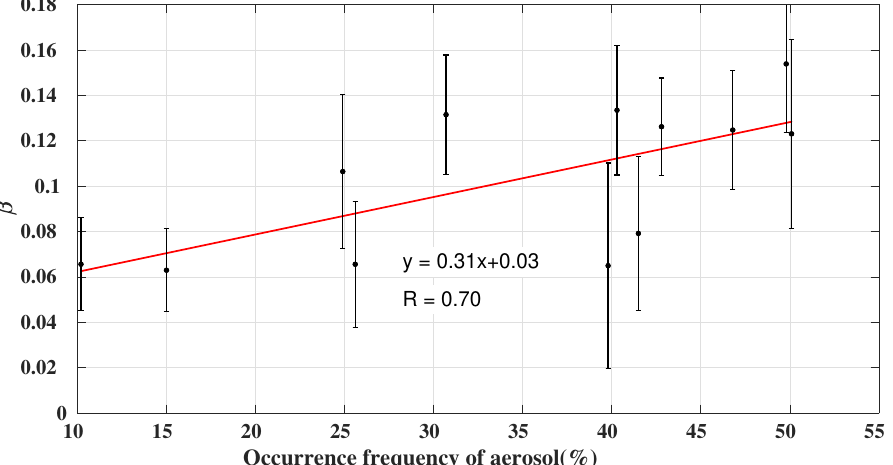
Figure 11. Correlation of the monthly average over the period from 2007 to 2009 of the Angström coefficient obtained from ESRA2, and the frequency of occurrence of aerosol over Tamanrasset observed with A − Train